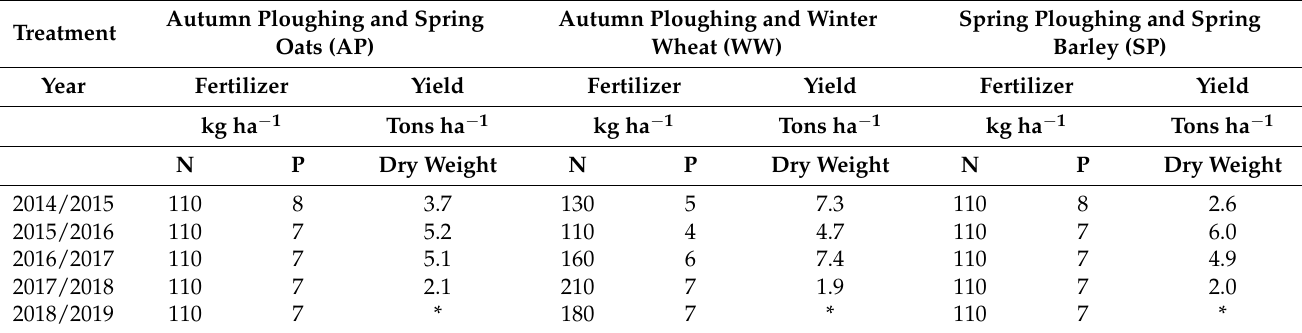
Table 3. Use of nitrogen (N) and phosphorus (P) fertilizers (kg ha − 1 ) and yield (tonne dry weight ha − 1 ).